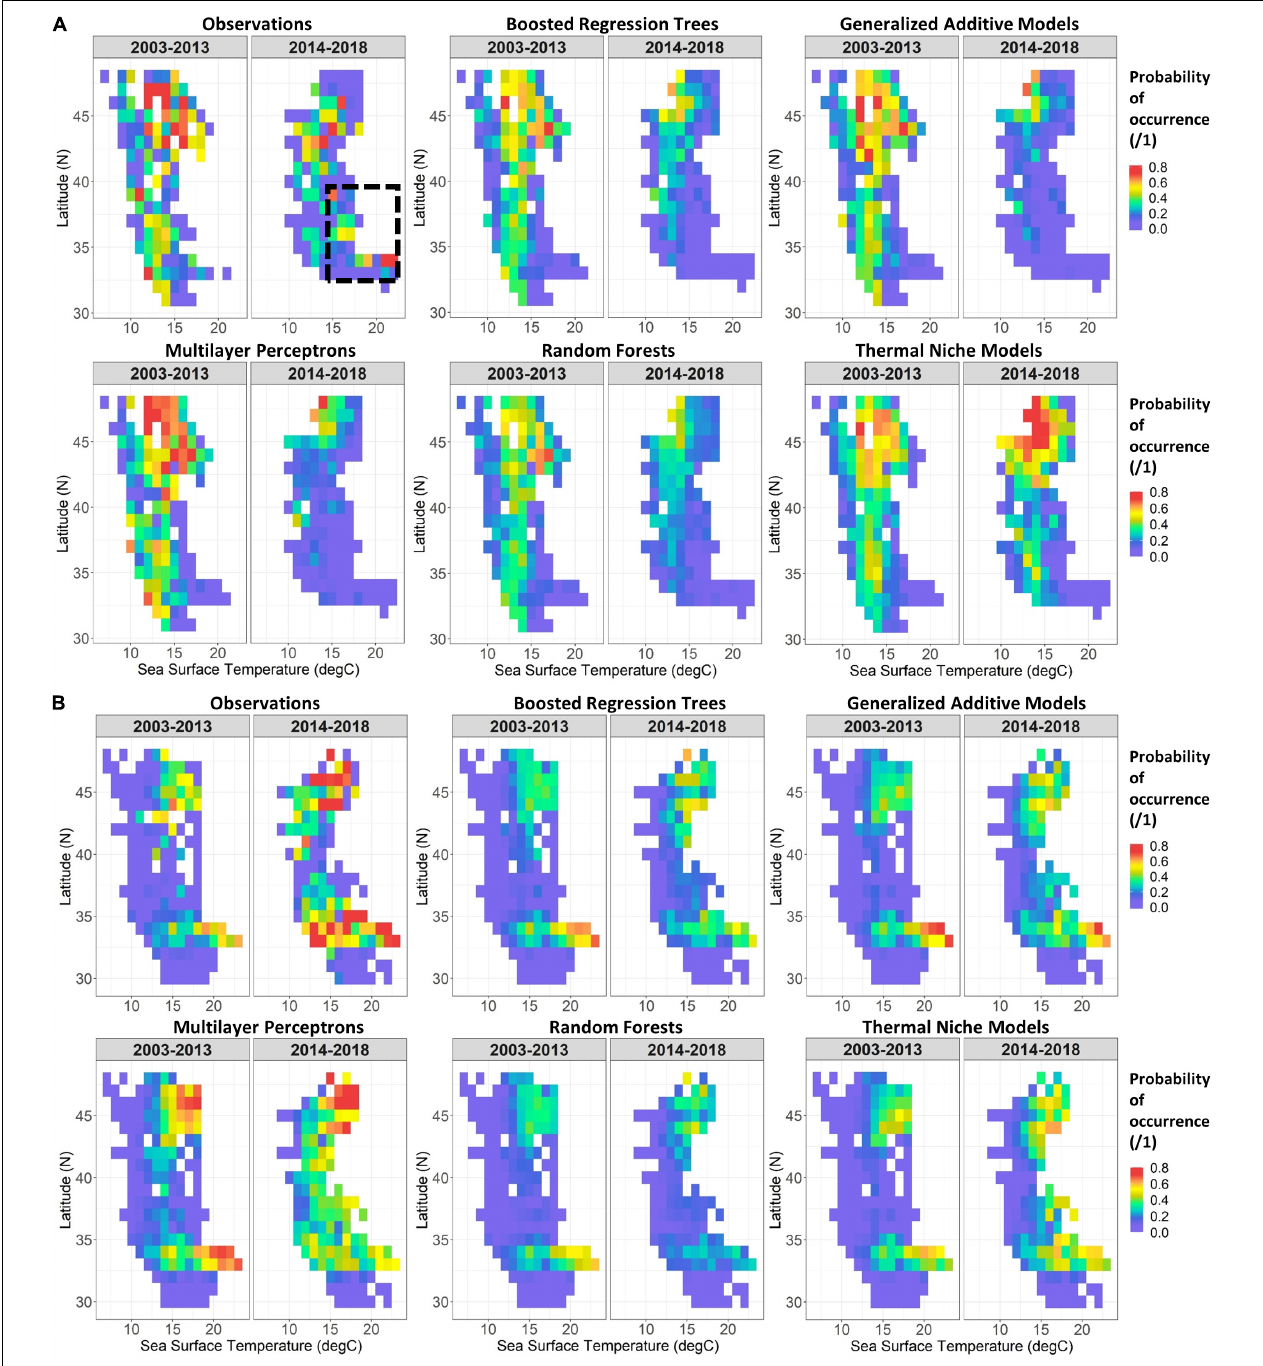
FIGURE 5 | Two-dimensional partial responses of Experiment 1 SDMs for adult sardine (A) and anchovy larvae (B) against SST and latitude, integrated across all other predictors. Predictions from the five SDM types are shown, as well as a summary of observations (mean probabilities of occurrence within 1 ◦ SST and latitude bins) for years 2003–2013 (left) and 2014–2018 (right). The black dash box in (A) draws attention to sardine observations from 2014 to 2018 which were poorly predicted by the